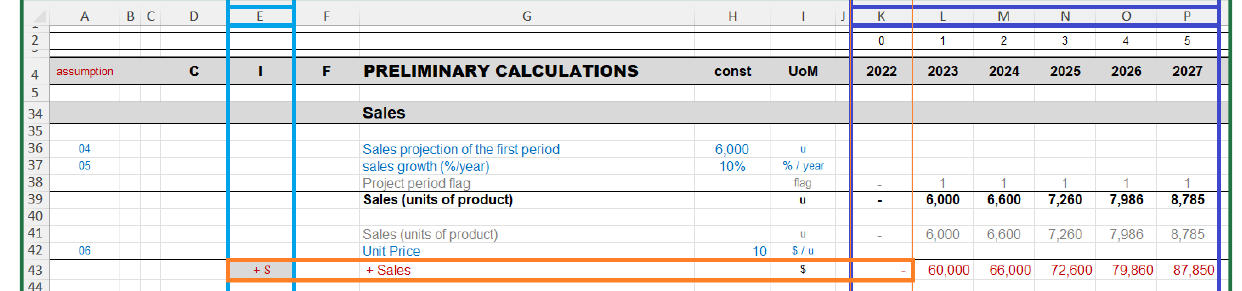
Figure 11. Cell K43 contains the value that has the same label of SplitScreenStrip!E13 and that is in the (H$9 + 1)-th column (“PreCalc” sheet).